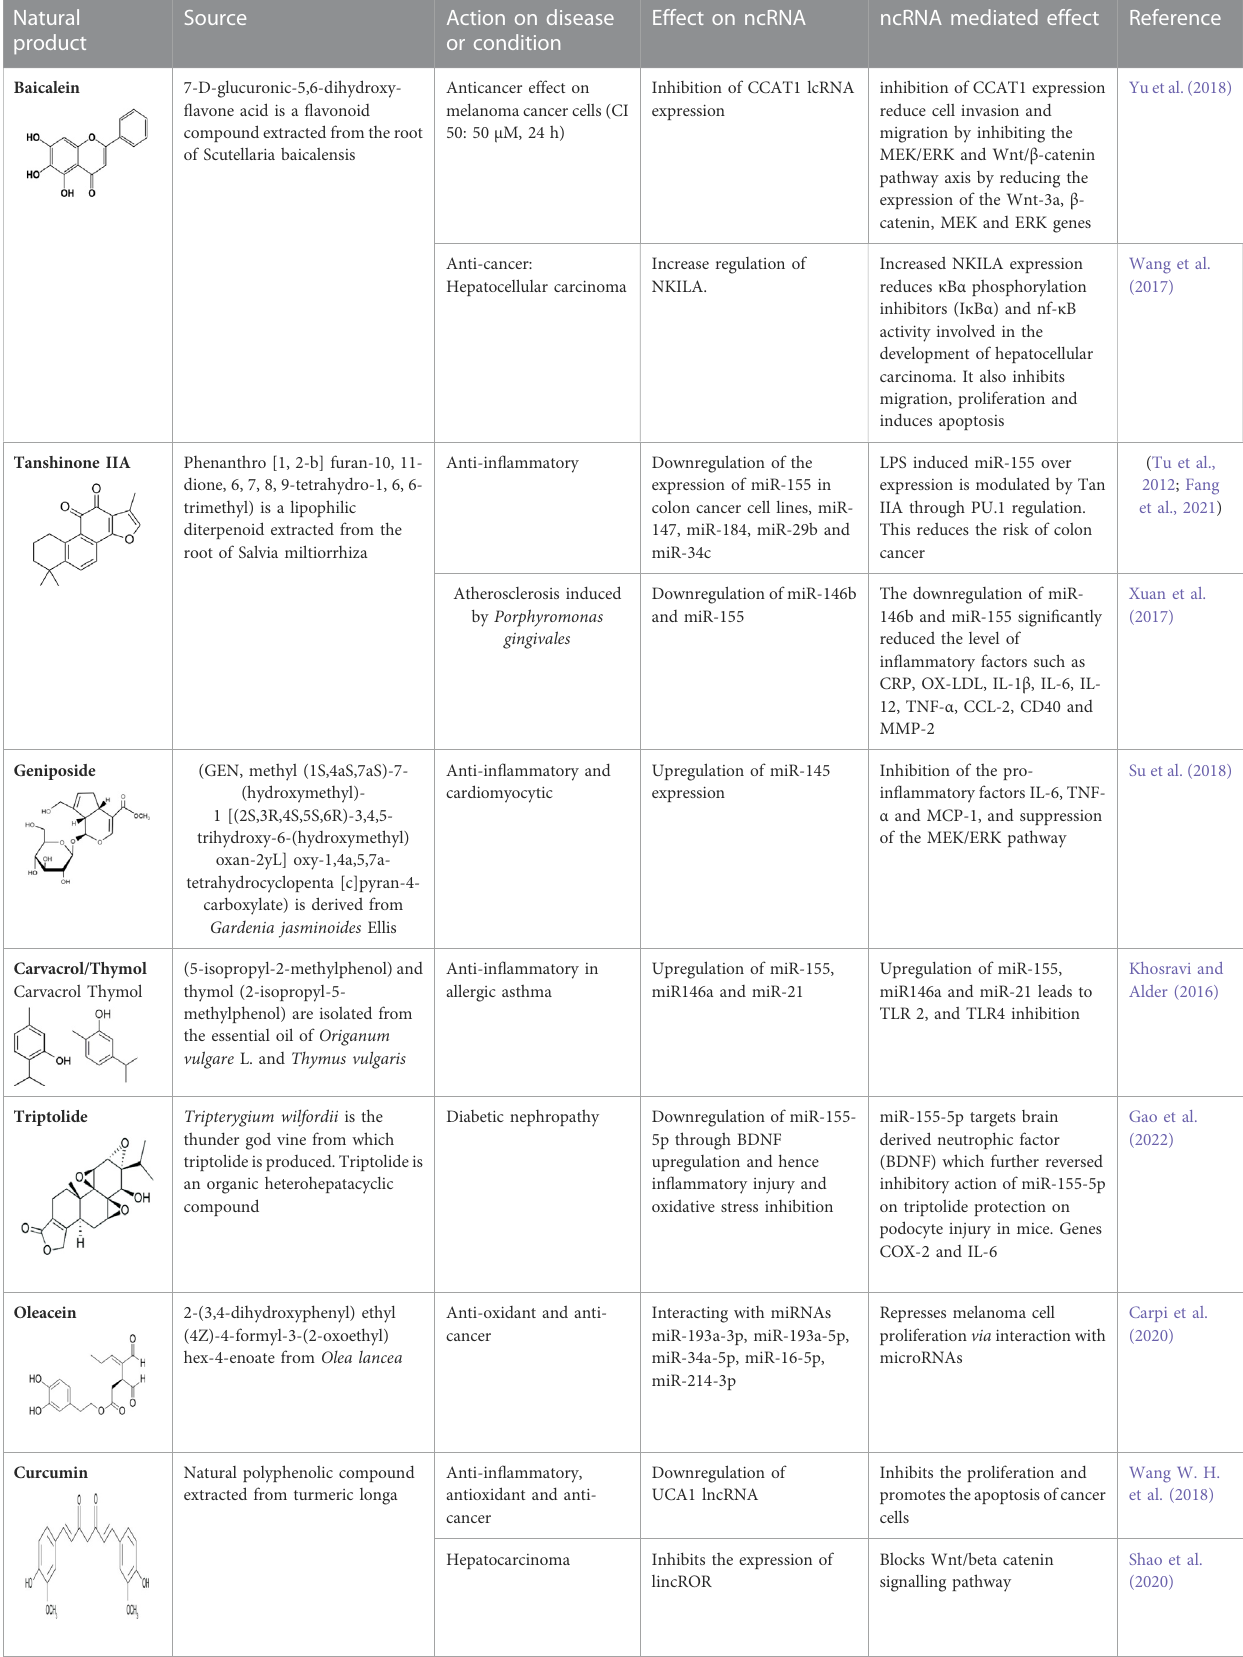
TABLE 3 A summary of Natural Products that Modulate Non-coding RNAs and its mediated effect in a given condition. Natural